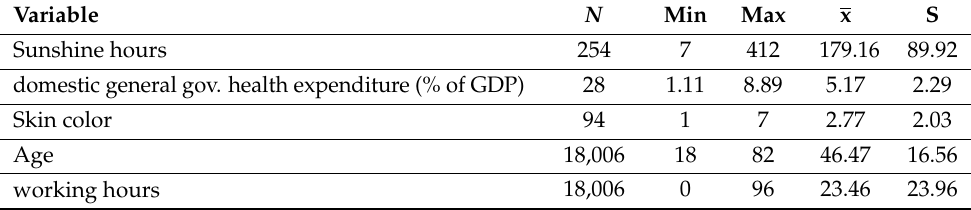
Table 4. Description for metric